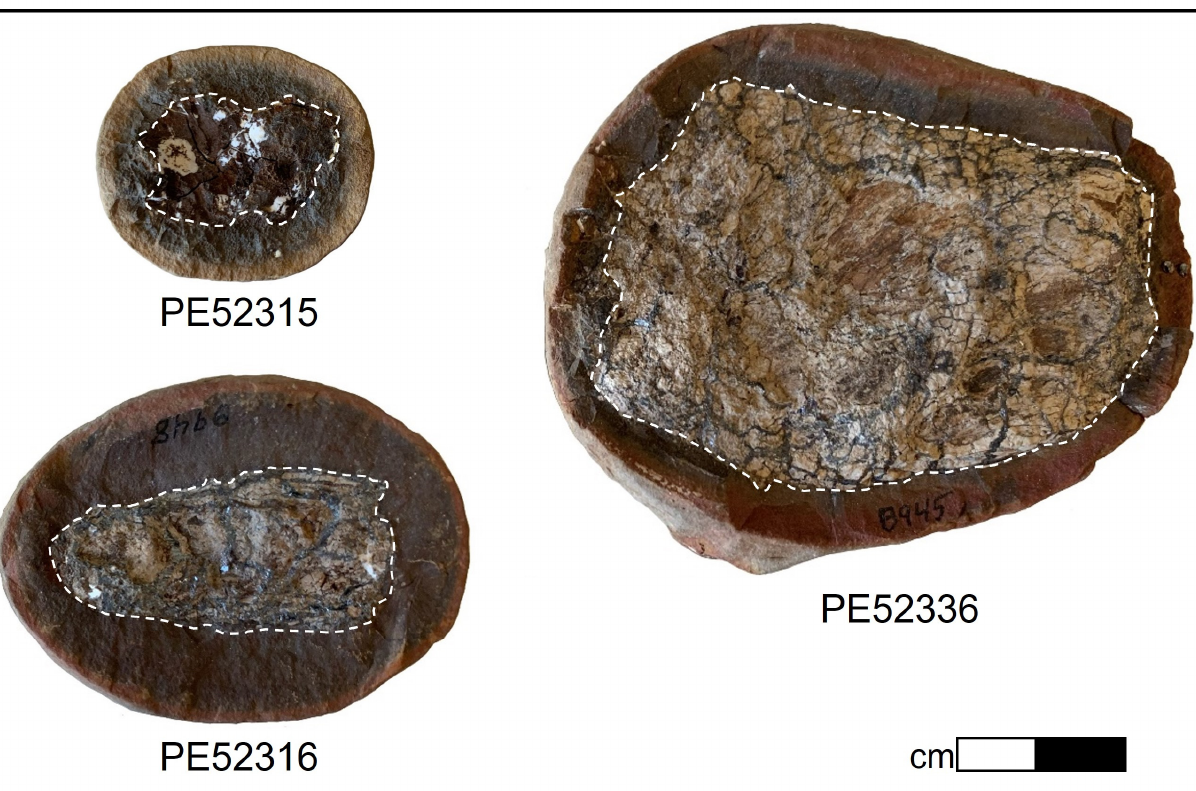
Figure 1. Images of the three samples used in this study. Regions are defined as the ‘Fossil’ and the ‘Matrix’ corresponding to the coprolite fossil region and the concretionary region, respectively, as demonstrated by white dashed lines. Subsamples of each region were used for geochemical analysis. ‘Matrix’ is used throughout to refer to the concretionary region, which is assumed to consist of primarily concretionary material plus potential external organic matter